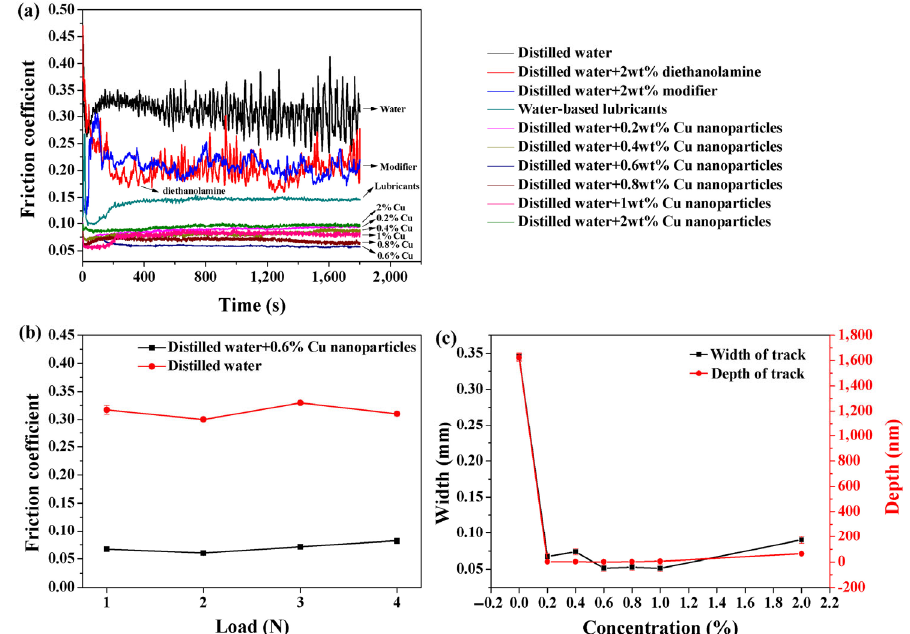
Fig. 7 The results of the tribological tests (a) variations of the friction coefficient with sliding time at different concentration of water-soluble Cu nanoparticles in contrast to modifier and diethanolamine, and water-based lubricants, (b) friction coefficient as a function of applied load, and (c) the depth and width of wear tracks (speed: 0.02 m/s, time: 30